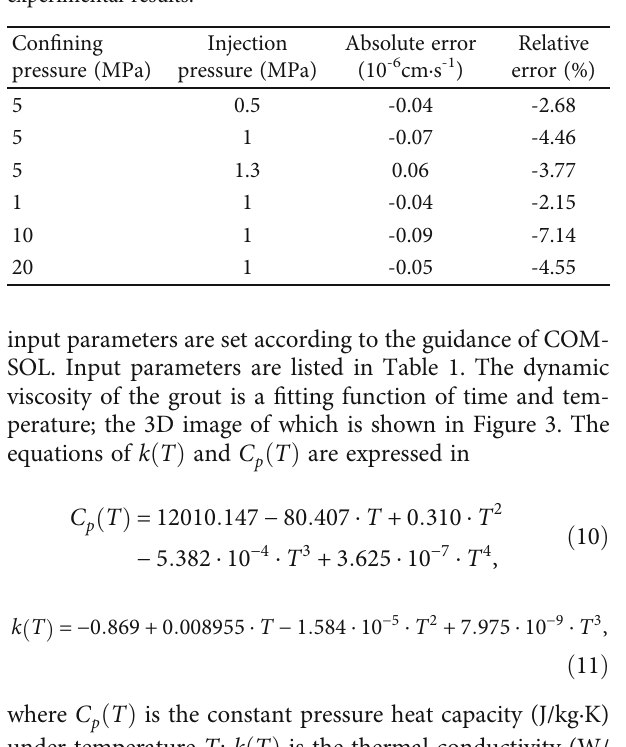
Figure 4: Comparison of fracture permeability obtained from experiments and COMSOL models at (a) 5 MPa con fi ning pressure ( P (b) 1MPa injection pressure ( P in ). Table 3: Error calculation of numerical model with respect to experimental